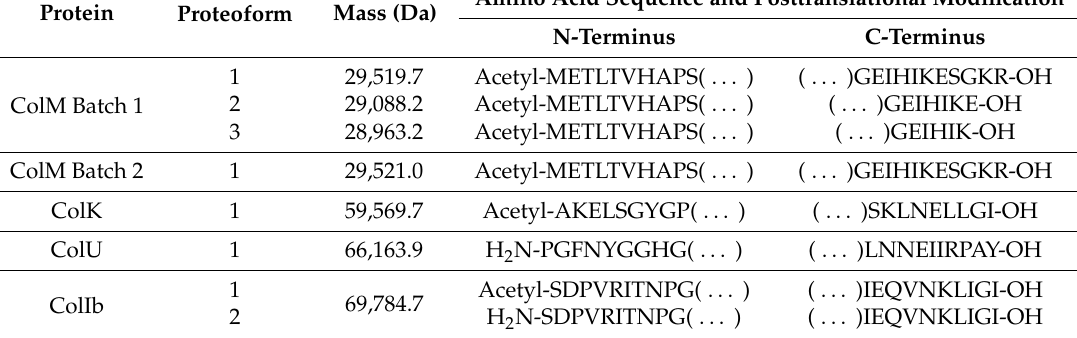
Table 2. Mass spectrometry—based analysis of the integrity of purified colicins by determination of the molecular mass and verification of the N- and C-terminal sequences by in-source decay